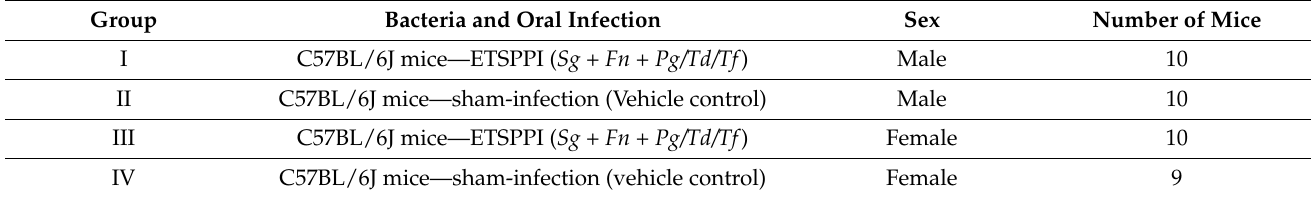
Table 1. Details of experimental and control groups ( n = 39 mice).